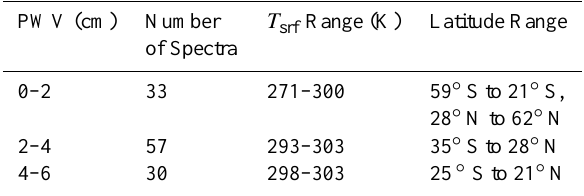
Table 1. Number of IASI spectra in each range of precipitable wa- ter vapor (PWV), and the associated surface temperature ( T srf ) and latitude range.